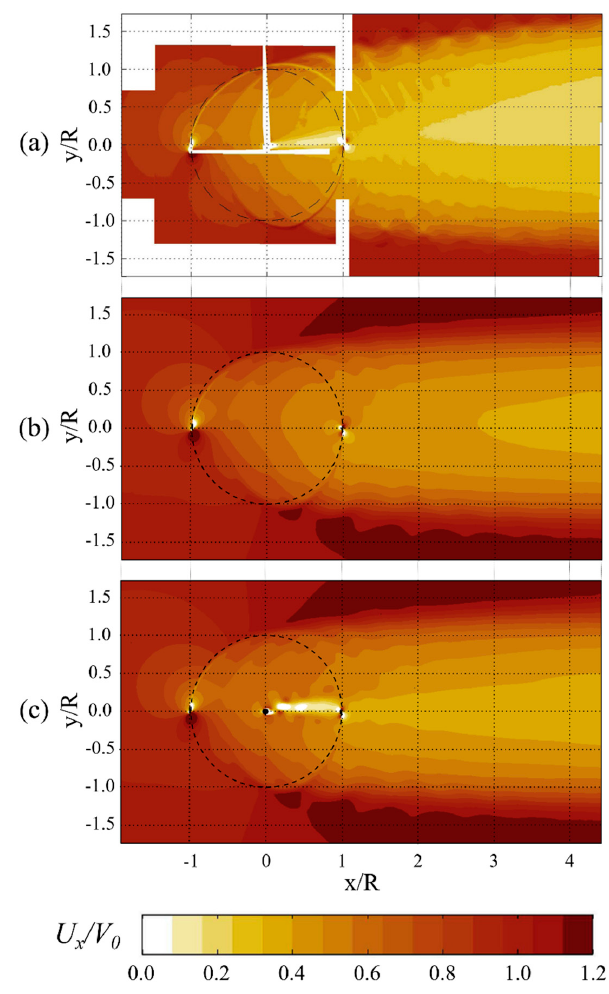
Figure 9. Contour maps of the U x velocity component, shown for ( a ) PIV [26]; ( b ) the rotor without shaft; ( c ) the rotor with shaft.